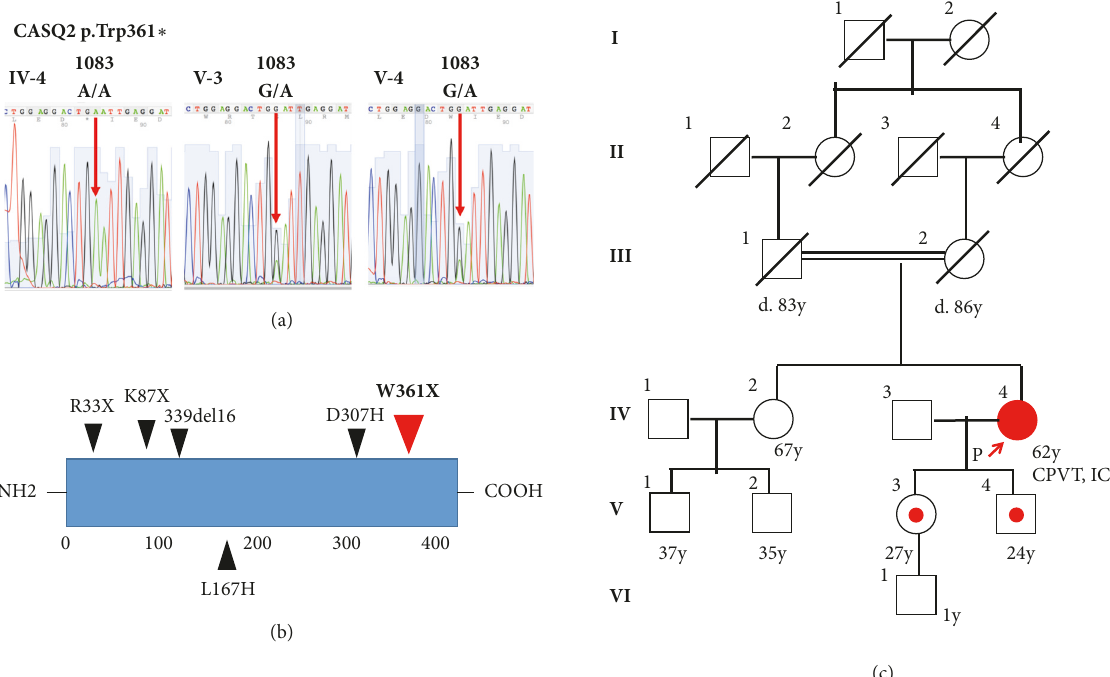
Figure 2: (a) Genetic characteristicsof the proband and offspring. The result of DNA sequencing in the index patient (IV-4) demonstrating a homozygous single G to A nucleotide substation at position 1083 of the CASQ2 gene leading to a Trp361 ∗ (=W361X) stop-codon mutation. A heterozygousmutation was identified in herdaughter(V-3) and son (V-4). (b) Schematictopology of CASQ2 , displaying the putative location of the W361X mutation (red arrow). (c) Pedigree of the index family. The proband is marked by an arrow. The results of the CASQ2 genetic screen were performed on the index patient and her children at an age of 27 and 24, indicating a heterozygous mutation (c.1038 C/G) in the CASQ2